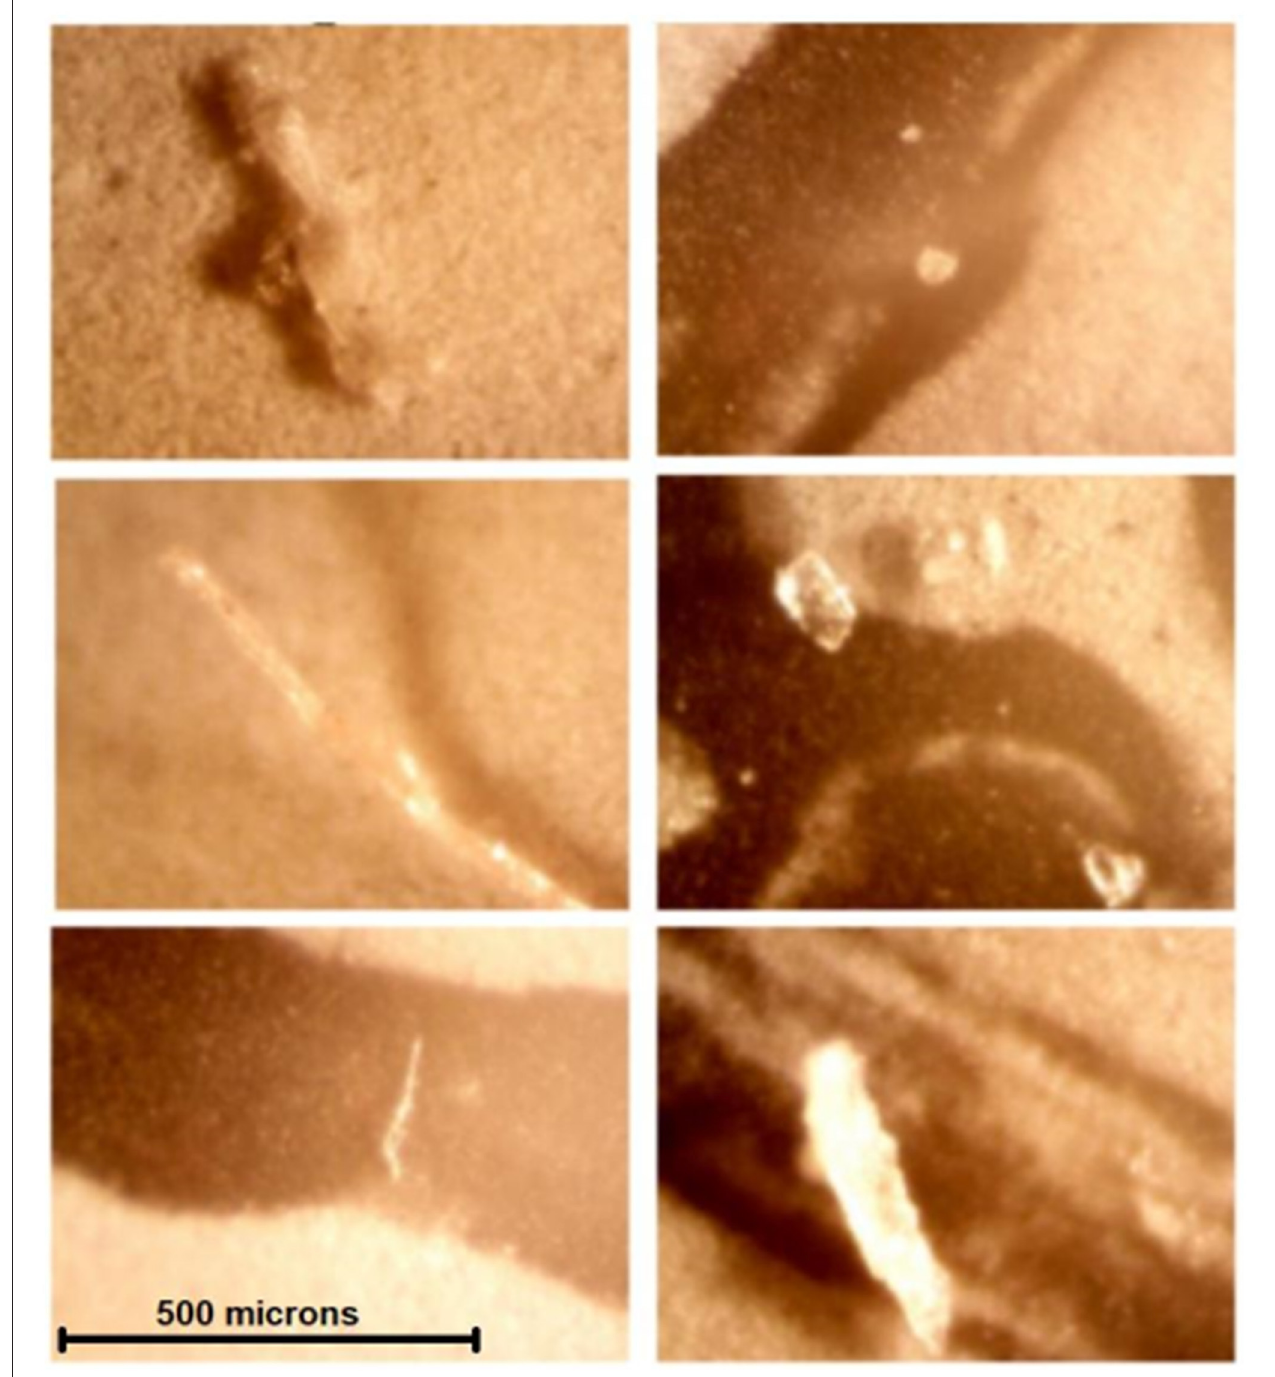
FIGURE 5 | Contaminants or crystals were found in all solutions examined by light microscopy—All images were obtained at the same magnification. Noncrystalline contaminants or crystals visualized are considerably larger than human capillary beds (5–10 microns). These are, clockwise, from top left, solutions A (sterile water), B (5% saline), I (3% saline), G (20% mannitol), L (20% mannitol), and P (23.4% saline).